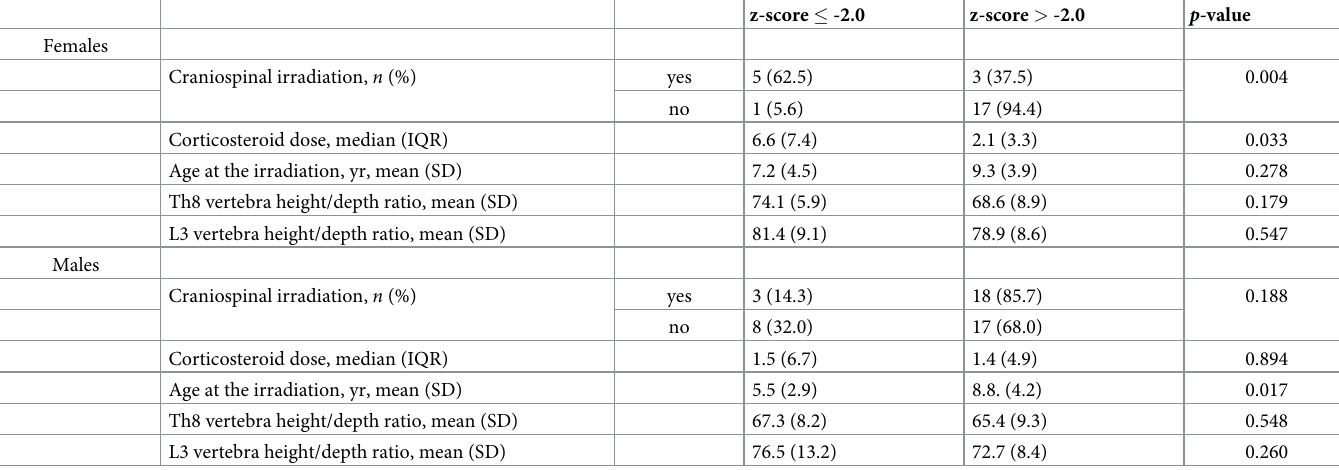
Table 4. Tumor treatments, treatment age and vertebral height/depth ratios in subjects with z-score � -2.0 and z-score > -2.0.